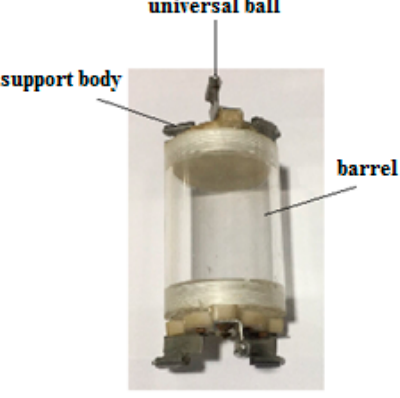
Figure 1. Structural diagram of wheeled capsule.